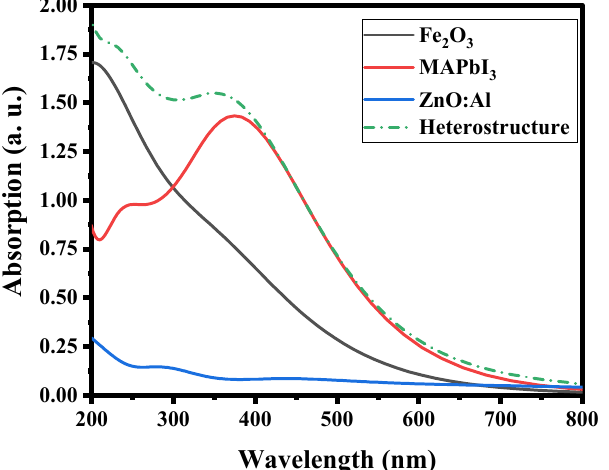
Figure 7 . Computed optical properties of Fe 2 O 3 (110), MAPbI 3 (001), ZnO:Al (001), and Fe 2 O 3 /MAPbI 3 /ZnO:Al heterostructure.